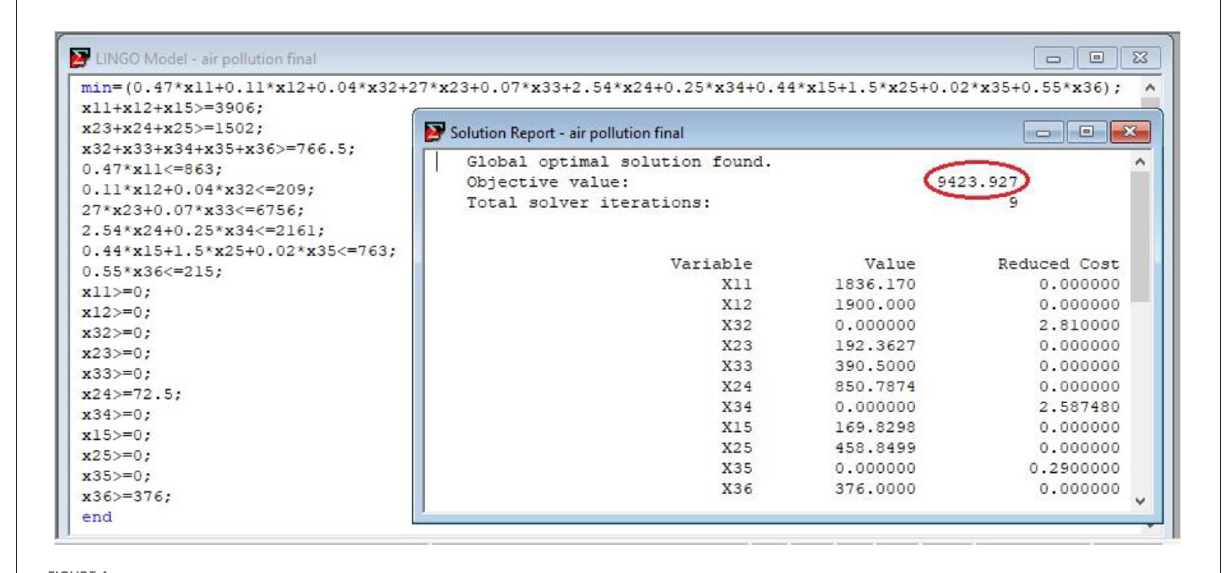
FIGURE4 Highest air pollution reduction of